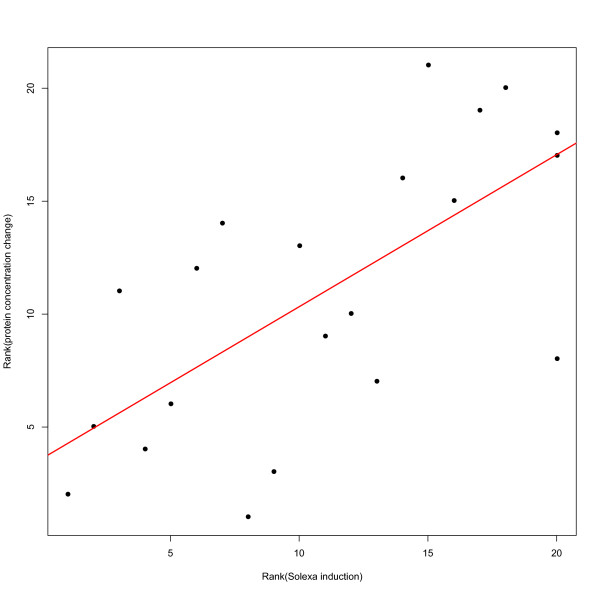
Correlation between change in protein concentration in the D. virilis hemolymph after infection and transcriptional induction of the corresponding transcript after infection. Each point represents a protein with data on both transcript and protein abundance. Ranked change in protein concentration after infection is plotted on the Y-axis, and ranked change in transcript abundance after infection is plotted on the X-axis. Spearman's ρ = 0.672, P = 0.0008.